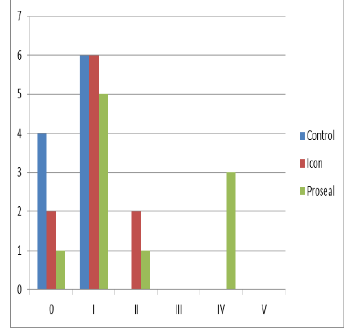
Figure 2: Bond failure site of the bonding